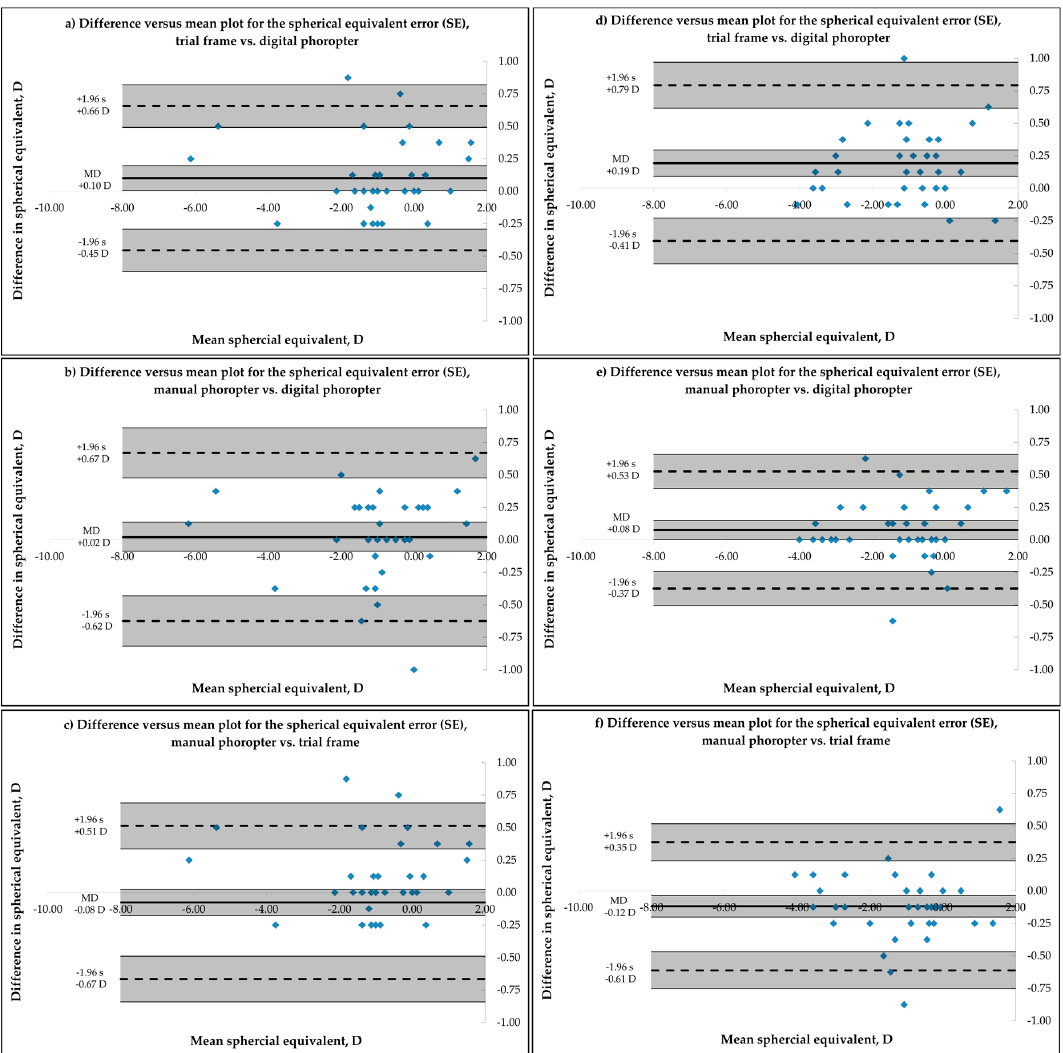
Figure 1. ( a – f ) Difference versus mean plot to compare the three subjective methods to determine the spherical equivalent refractive error (SE) of the left eye measured by examiner 1 ( n = 36, Figure 1a–c) and 2 ( n = 38, Figure 1d–f). ( a ) and ( d ) trial frame vs. digital phoropter; ( b ) and ( e ) manual phoropter vs. digital phoropter and ( c ) and ( f ) manual phoropter vs. trial frame. Solid line indicates the mean difference, while dashed lines represent the upper and lower limit (±95% limit of agreement). MD = mean difference and s = standard deviation. Shaded areas present 95% confidence interval limits for the mean difference and 95% limits of agreement.